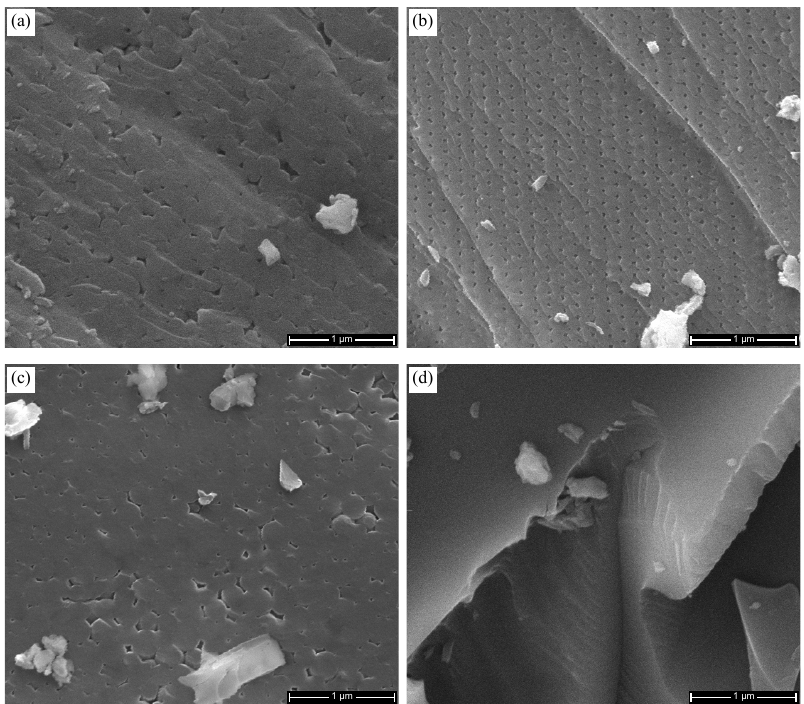
Figure 1. SEM images of unetched opal-AG and opal-AN ( a , b ) G13767 (collection of opal-AG samples from Lightning Ridge, New South Wales, Australia) showing ( a ) irregular pattern of an opaque blue sample—no POC; ( b ) regular pattern on an orange glass sample but with spheres too small to exhibit POC); ( c ) G8608 (opal-AG, white opal showing POC from White Cliffs, New South Wales, Australia); and ( d ) G32740 (opal-AN (hyalite) from Valec, Czechia).